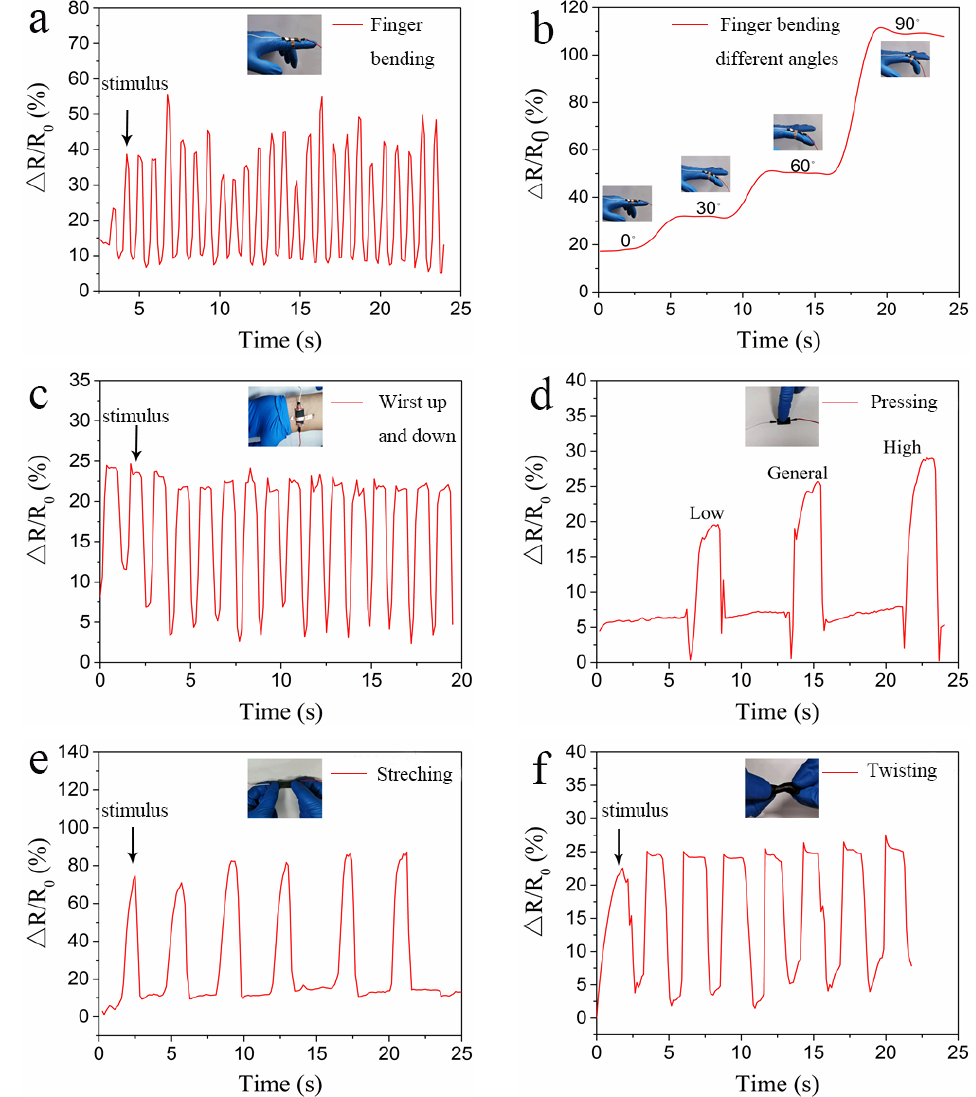
Figure 5. Wearable flexible sensors based on P(AA-HEMA)/GO hydrogels. ( a ) the sensor for monitoring the motion of the fingers, the (related original resistance of the sensor) R 0 was 1155 Ω ; ( b ) the hydrogel sensors adhered to the gloves with the finger bending at different angles, the R 0 was 1115 Ω ; ( c ) the sensor for monitoring the motion of the wrist, the R 0 was 1092 Ω ; ( d ) pressing the hydrogel sensor to detect its sensitivity, the R 0 was 6300 Ω ; ( e ) stretching, the R 0 was 3968 Ω ; ( f ) twisting, the R 0 was 5134 Ω. The size of the hydrogels in ( a – c ) were different from the size of the hydrogels in ( d – f ).